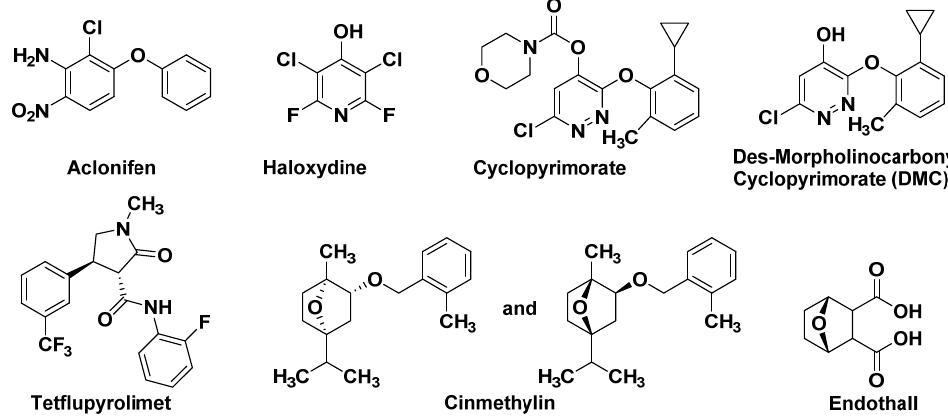
Figure 2. The structures of the inhibitors with new